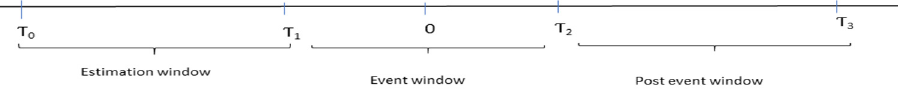
Figure 1. Timeline for an event study. Table 1. Event window per each index, with the event date in bold.